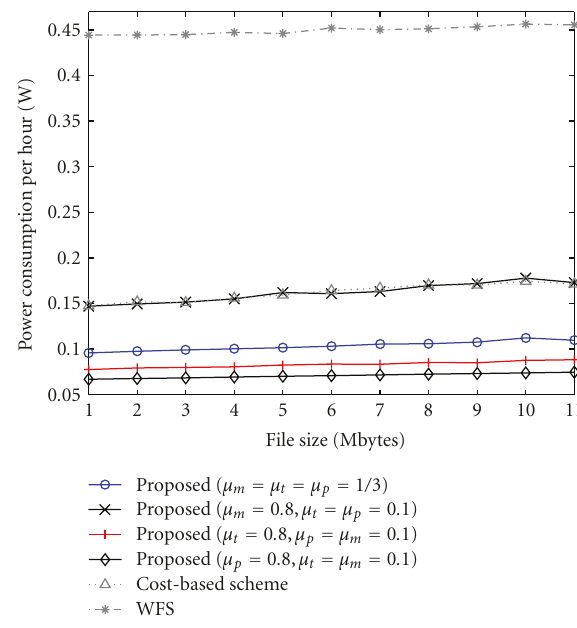
Figure 7: File size per session rate versus power consumption per minute when the TCP tra ffi c ( ρ = 1) is